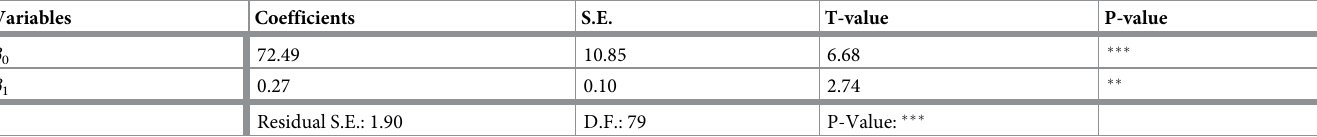
Table 1. The linear regression analysis of quarterly GDP growth rate and quarterly year-on-year CPI growth rate. Variables